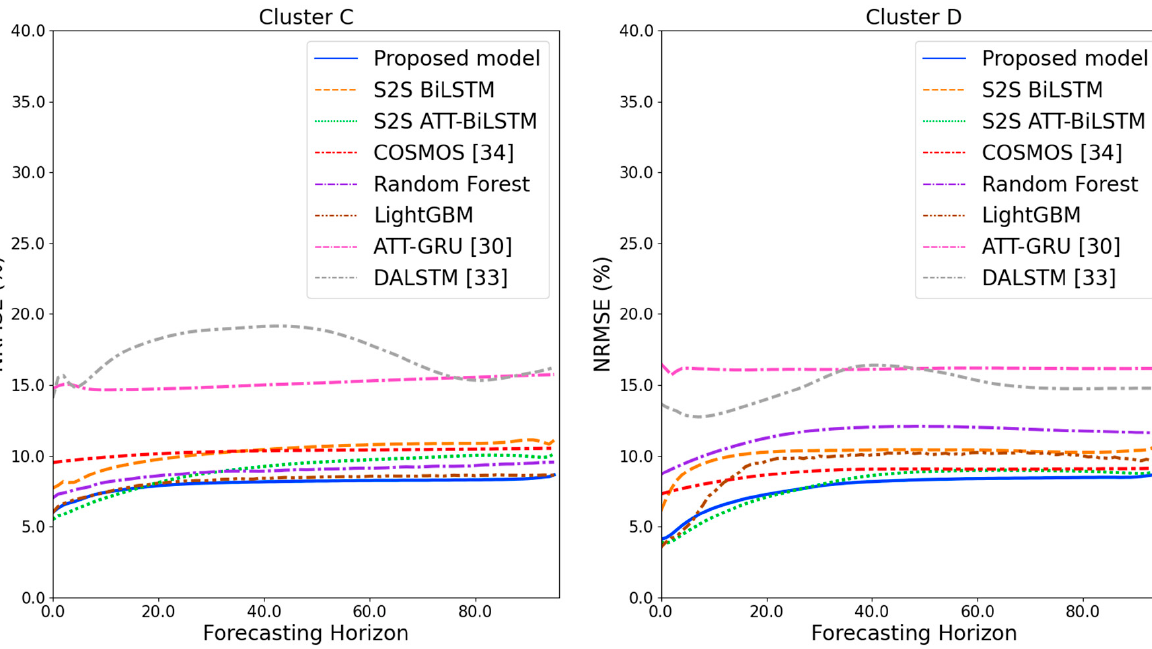
Figure 14. NRMSE results of clusters C and D over the entire forecasting horizon (%).